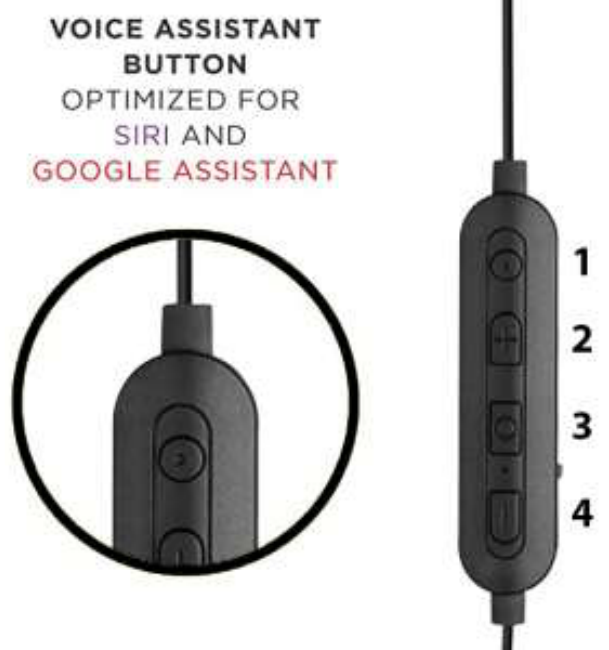
Figure 10. Typical headset button controller.